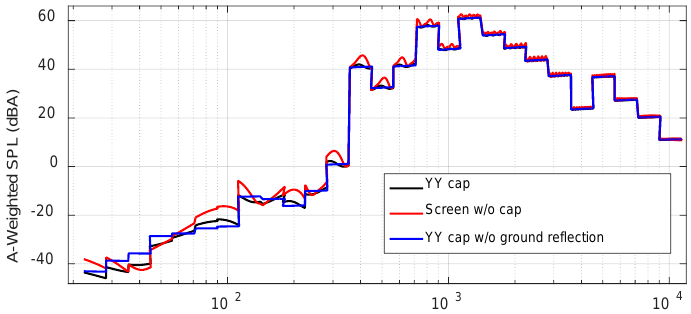
Figure 28. A-weighted SPL spectrum in 1 Hz bands in Configuration 4 (Ambulance–Balcony) for ‘YY’ cap with and without ground reflection. The screen barrier SPL spectrum is shown as a reference.